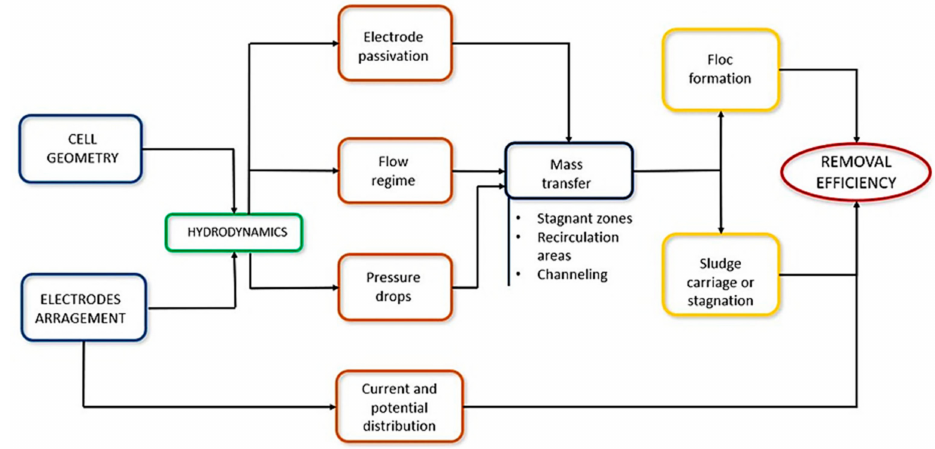
Figure 5. Conditions that influence the efficiency of an EC process for water treatment.